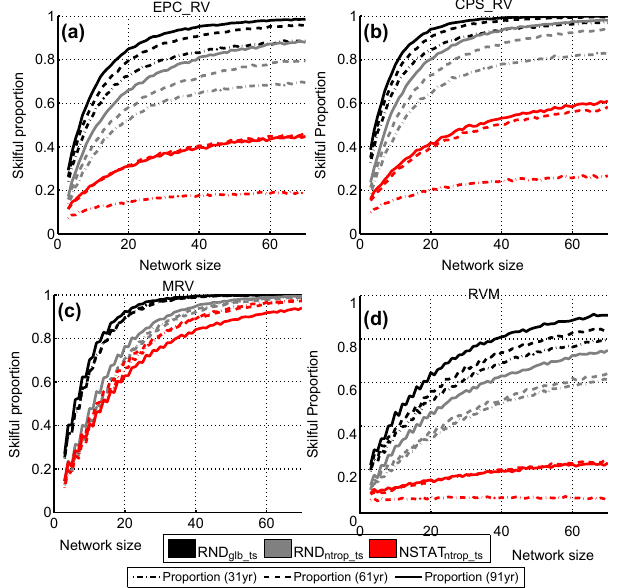
Figure 9. A comparison of all the RND glb_ts reconstructions using 499 years of data (black) and when using limited calibration win- dows of 31 (blue), 61 (green), and 91 years (red). The 5th (dashed), 50th (solid line) and 95th (dot-dashed) percentiles of correlation co- efficients are shown for each of the window lengths and for recon- structions using the 499 years of data. Correlation coefficients are calculated between the reconstructed running variance and ENSO running variance ( y axis), plotted against the proxy network size ( x axis). Panels (a – d) show the comparison for the four reconstruc- tion methods discussed in Sect.